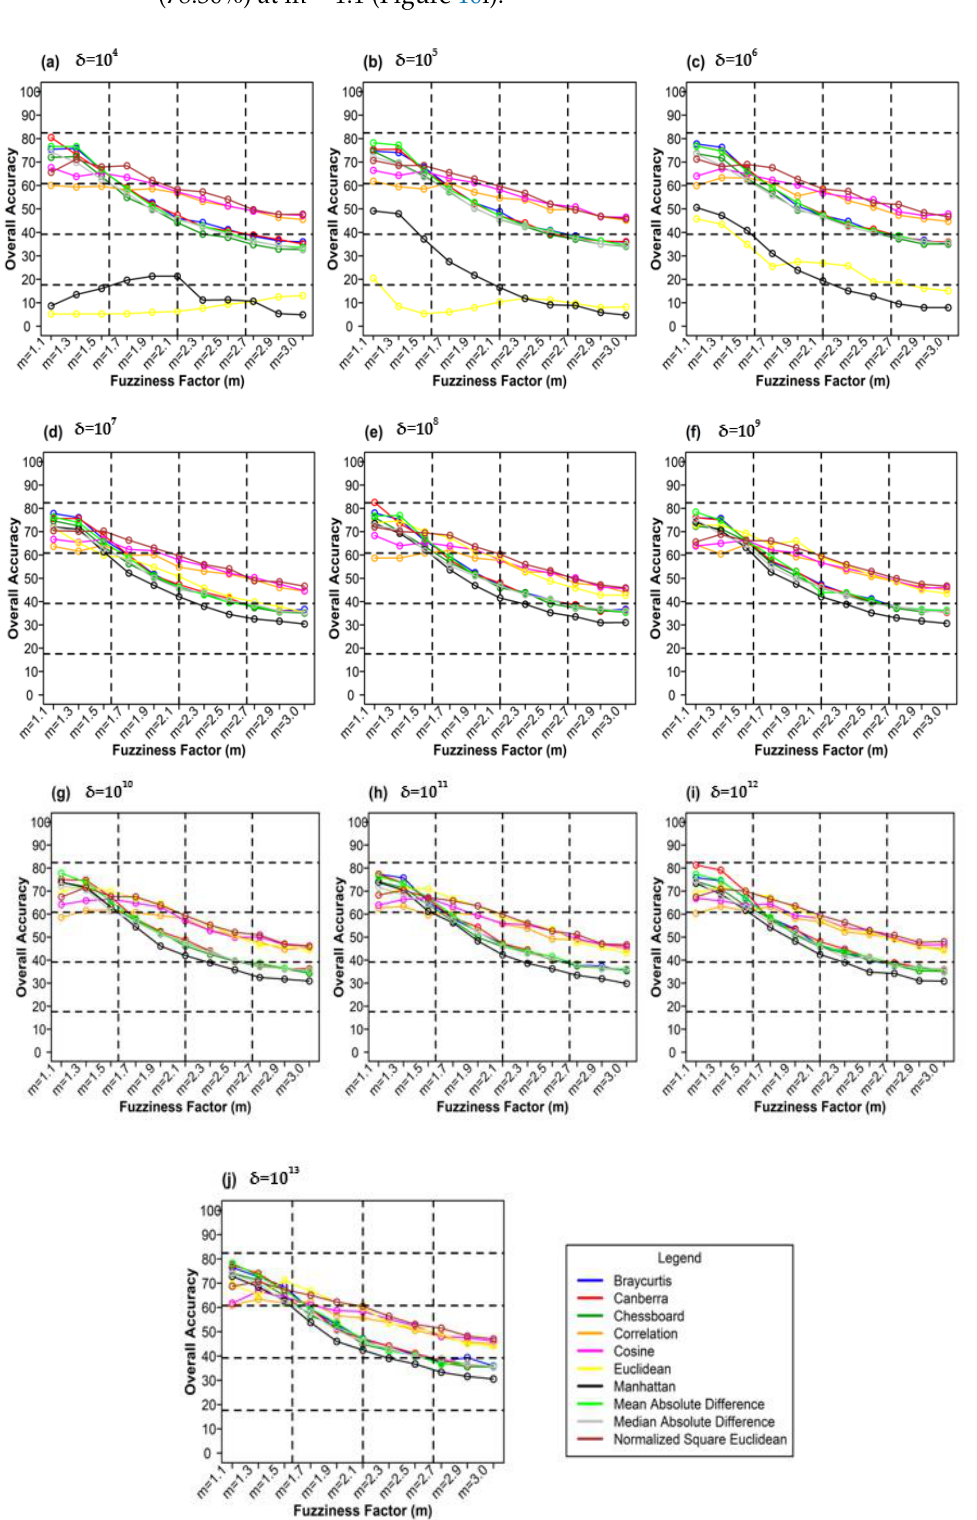
Figure 10. Comparison of overall accuracy in NC classifier for applying different distance measures, m (1.1 – 3.0), and ( a – j ) for site 1 (Haridwar).